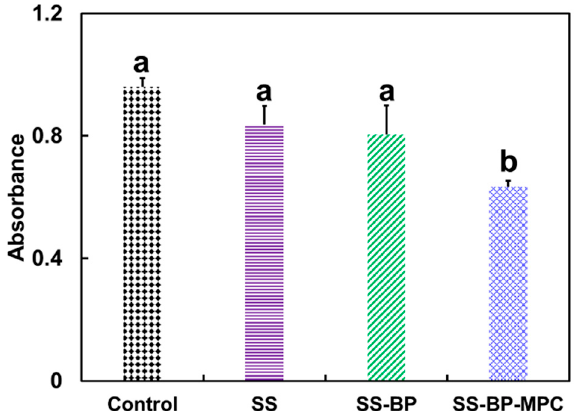
Figure 7. Quantitative analysis of bacterial adherence onto the surface of pristine SS, SS-BP, and SS-BP-MPC composites co-cultured with S. aureus for 12 h (n = 3). The S. aureus bacteria in the lysogeny broth (LB) medium without any samples served as a control group. Data with different letters mean they are significantly different on multiple comparison at α = 0.05 using the Tukey test.